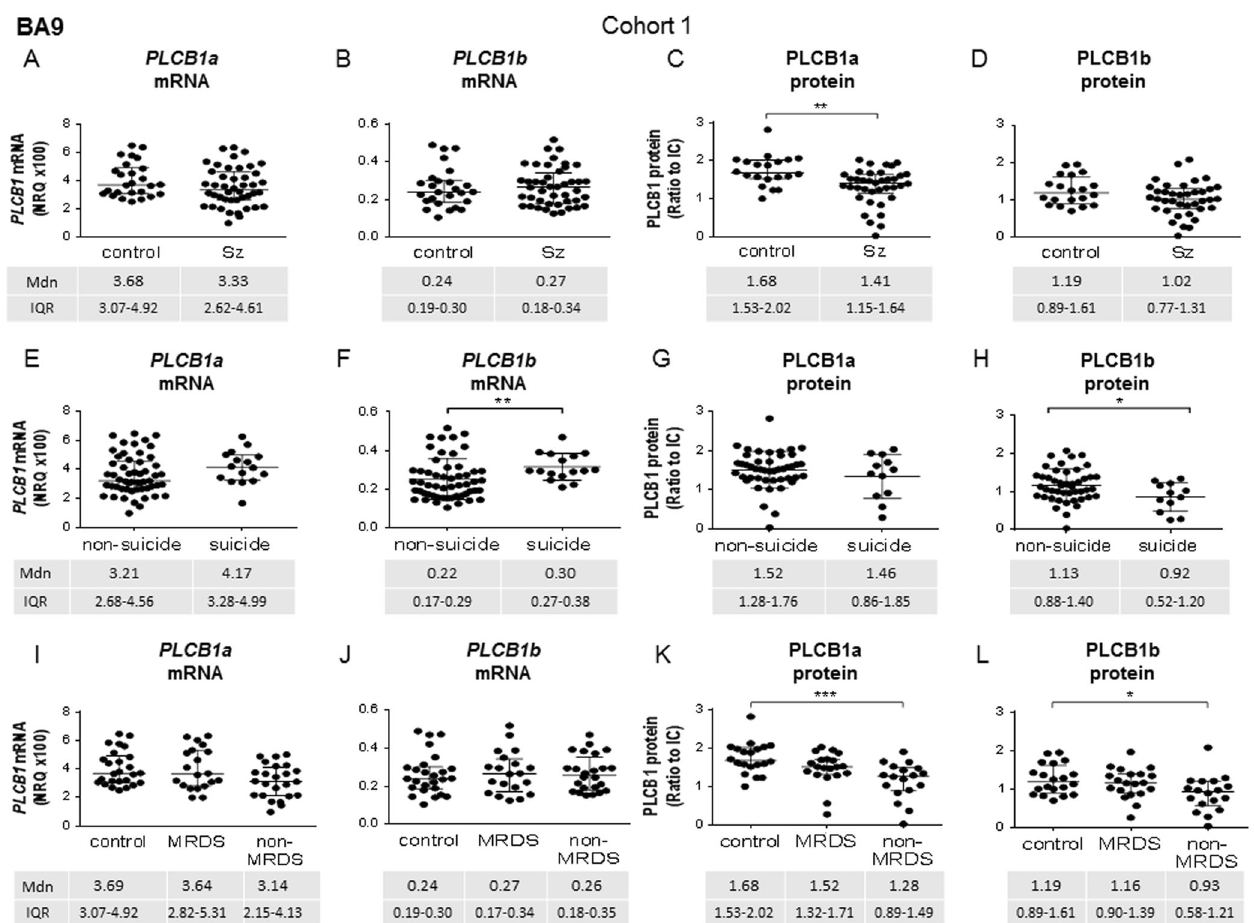
Fig. 2 PLCB1a and PLCB1b mRNA ( left ), and PLCB1a and PLCB1b protein ( right ) levels in cohort 1 measured in tissue from BA9, analysed as Sz vs. control ( a – d ), as suicide completers vs. non-suicide ( e – h ), and with Sz subjects divided into MRDS and non-MRDS compared to control ( i – l ). Error bars show median (Mdn) and